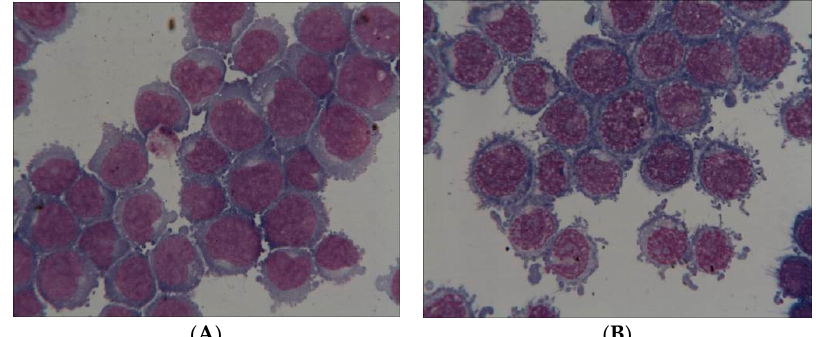
Figure 4. JURKAT cells: Image after normoxia ( A ) and after 18 hours of hyperoxia ( B ).